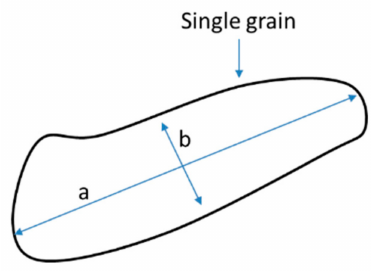
Figure 4. Schematic diagram for the dimensions in which the average grain size is measured.